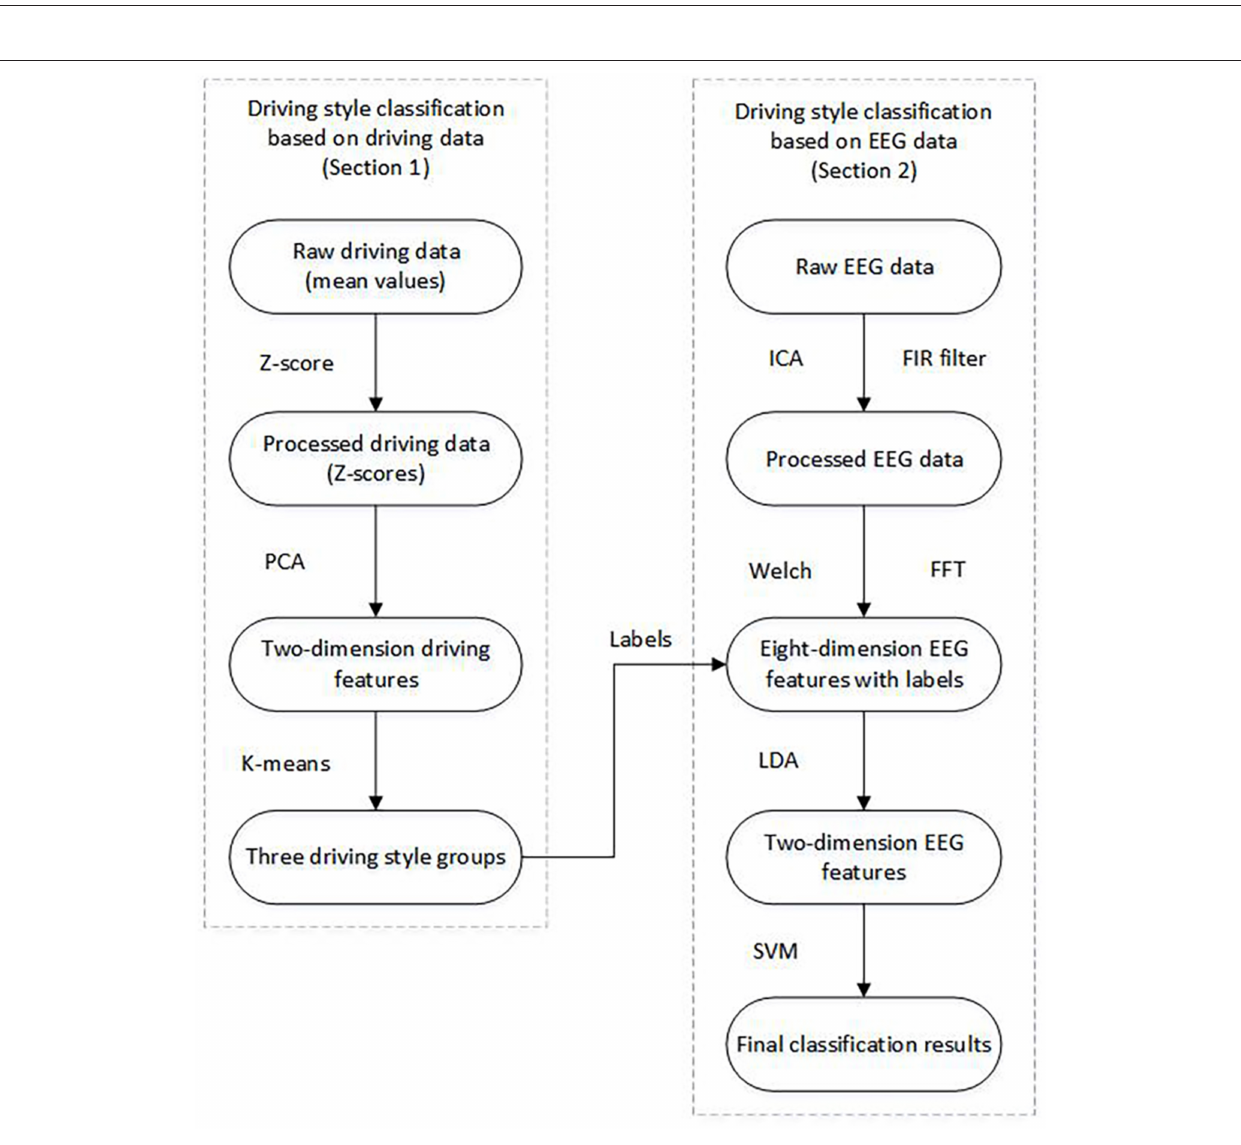
FIGURE 2 | Flow chart of the EEG-based driving style